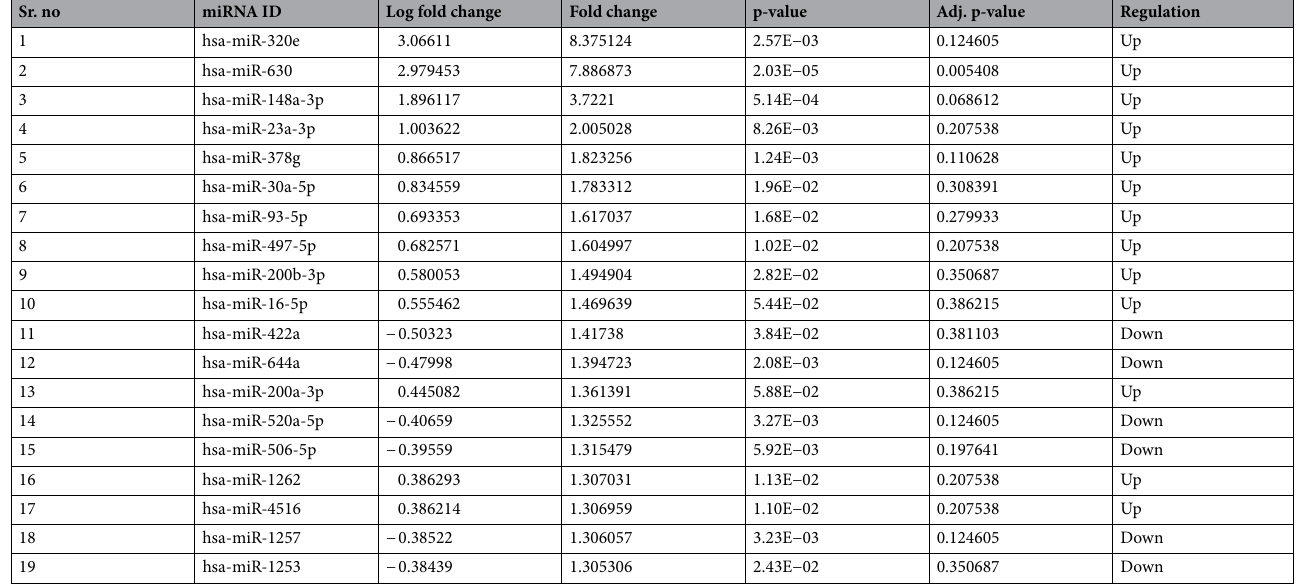
Table 2. Differentially expressed human milk exosomal miRNAs in HIV-1 infected mothers.